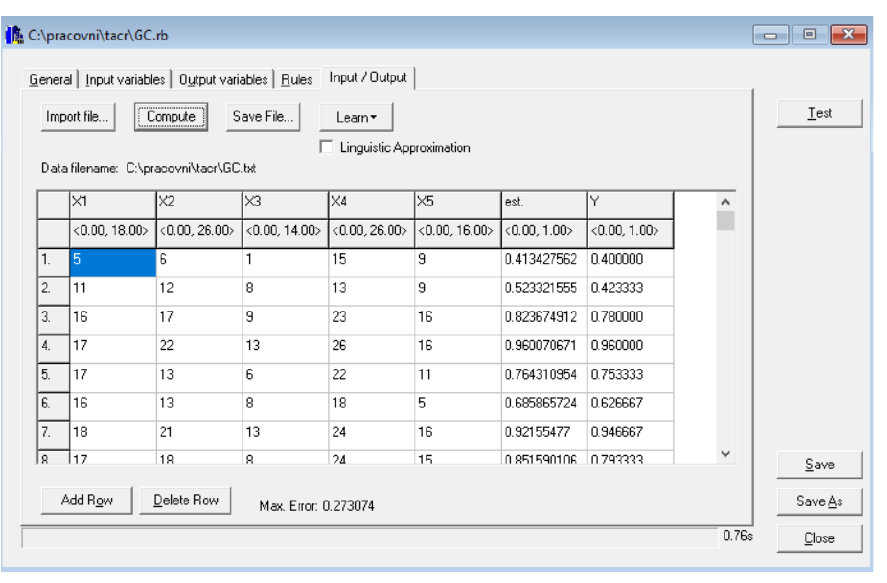
Figure 8. Data for GC evaluation and linguistic learning.